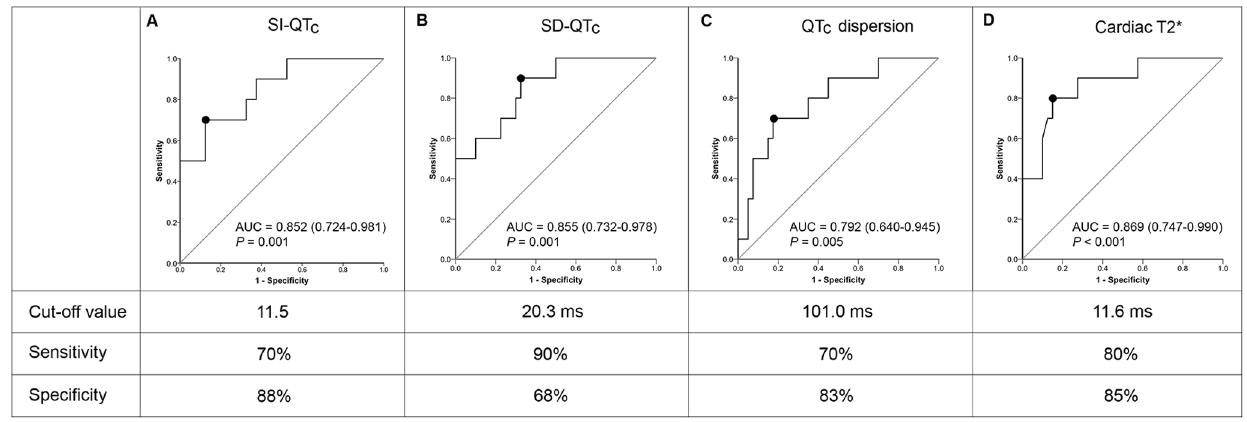
Figure 4. ROC curves of SI-QT c (A), SD-QT c (B), QT c dispersion (C), and cardiac T2* (D) for predicting the presence of adverse cardiac events. The optimal cut-off value (labeled as the black dot on the ROC curve), sensitivity, and specificity of each individual parameter are shown. Data in the parenthesis indicate 95% confidence interval of the area under curve (AUC). QT c =corrected QT interval; SI-QT c =smooth index of corrected QT intervals; SD-QT c =standard deviation of corrected QT